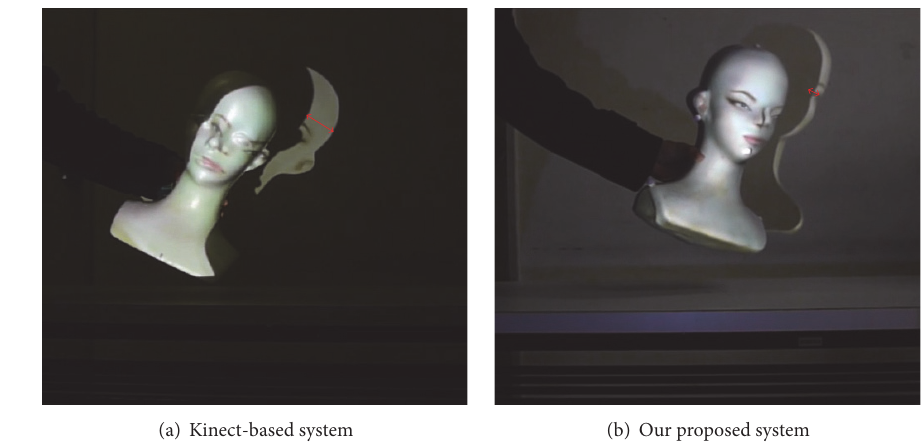
Figure 10: Projection errors with faster movement.